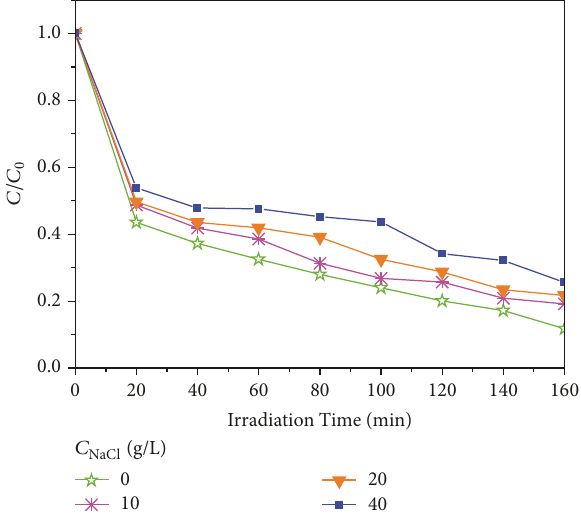
Figure 10: Influence of temperature over Sr 0.7 K 0.3 TiO 3 @PC- polyHIPEs for photocatalytic decomposition MB under visible